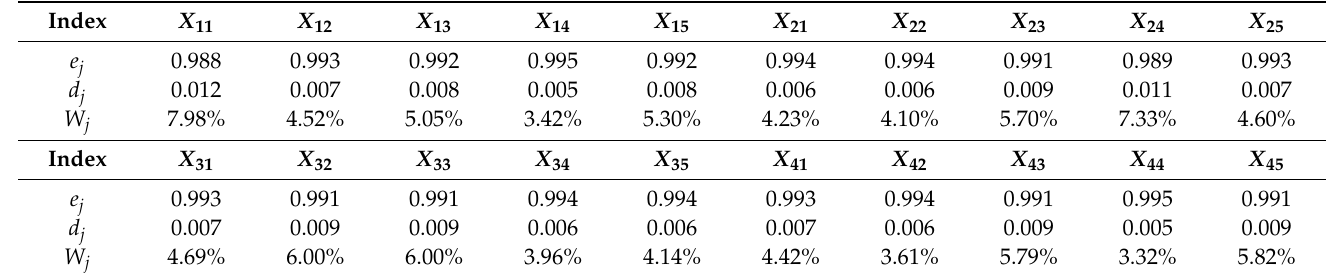
Table 6. Entropy value and weight of each index.